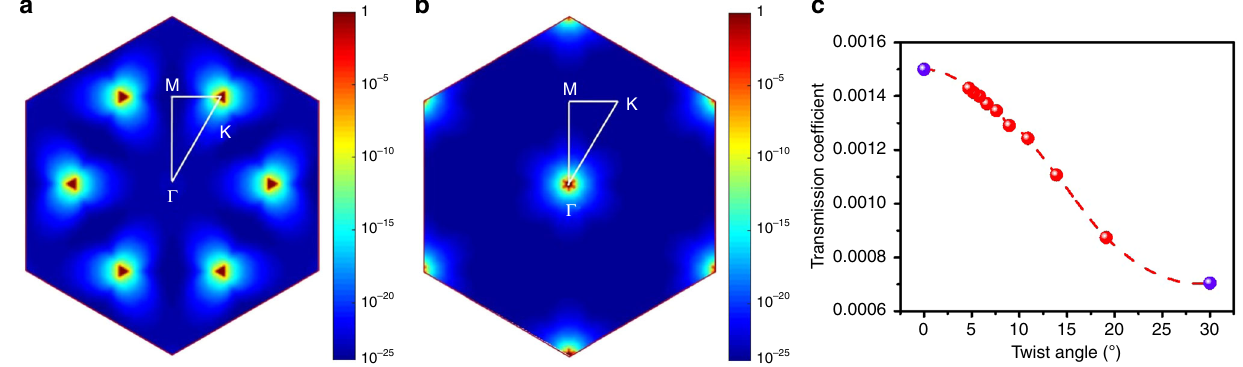
Fig. 4 Theorical simulations. a , b Simulated K-space transmission hot mappings for the 0°- and 30°-twisted MoS 2 /Gr heterojunctions. c Transmission coef fi cient as a function of twist angles. Red points are calculated by WKB method and blue points are calculated by DFT